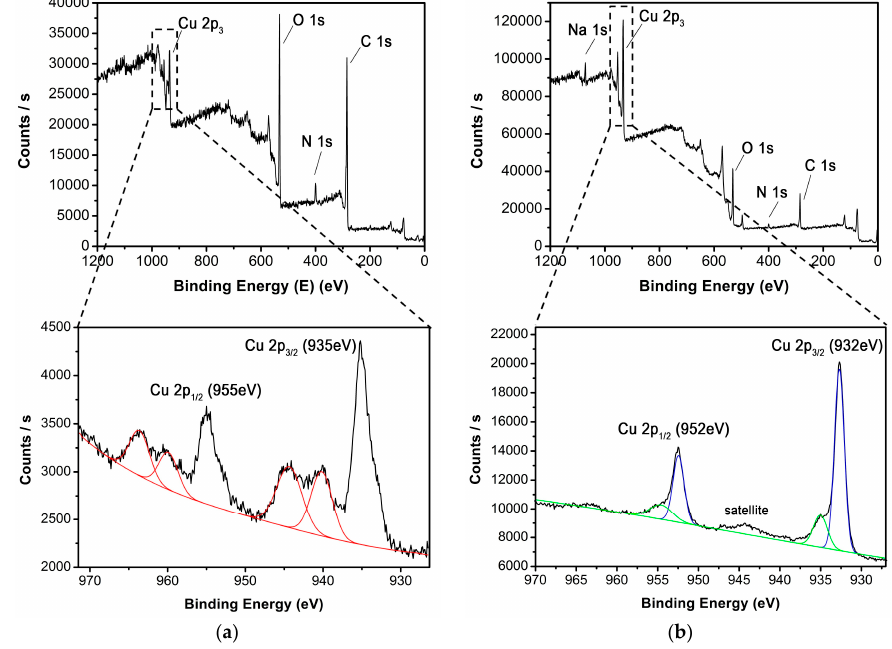
Figure 3. XPS spectra (survey and Cu 2p region) of ( a ) Cu(II)-MOF and ( b ) Cu@Cu 2 O core-shell Figure 3. XPSspectra(surveyandCu2pregion)of( a )Cu(II)-MOFand( b )Cu@Cu 2 Ocore-shellnanocatalyst. nanocatalyst.